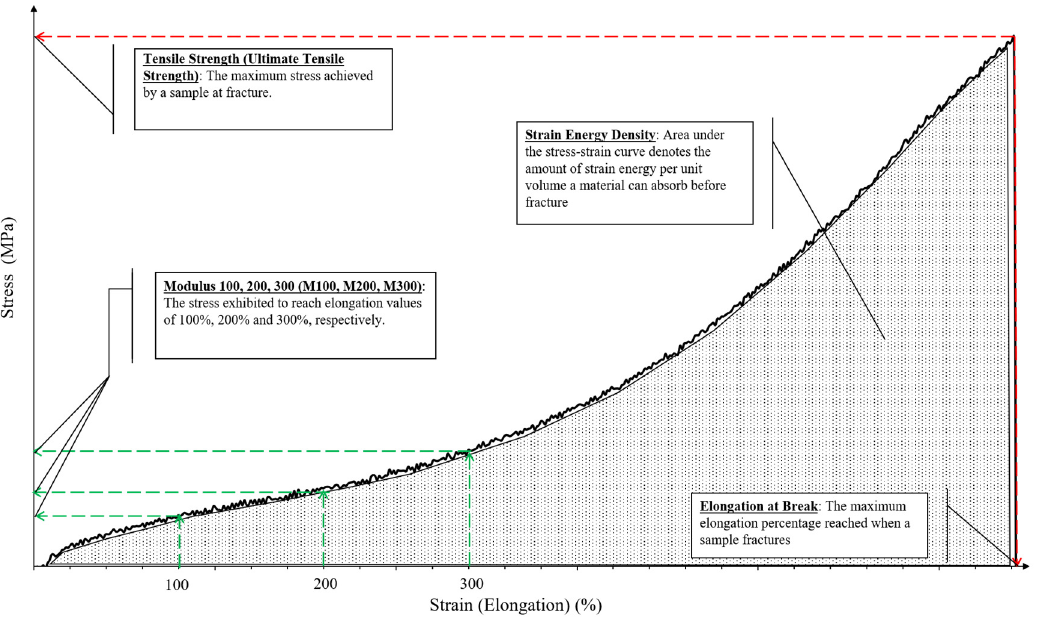
Figure 6. Sample stress–strain curve for rubber materials.